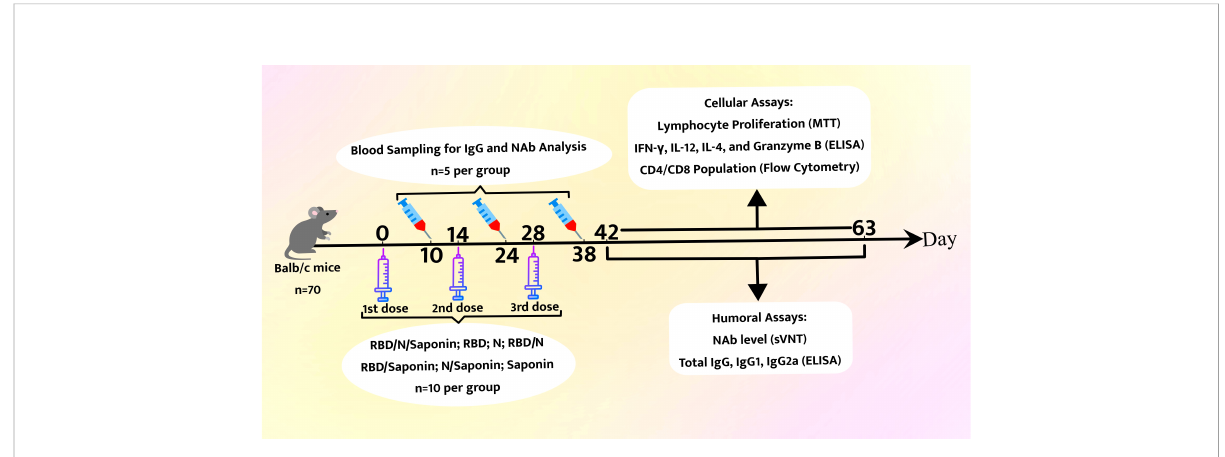
FIGURE 2 Schematic overview of Mouse immunization and analysis